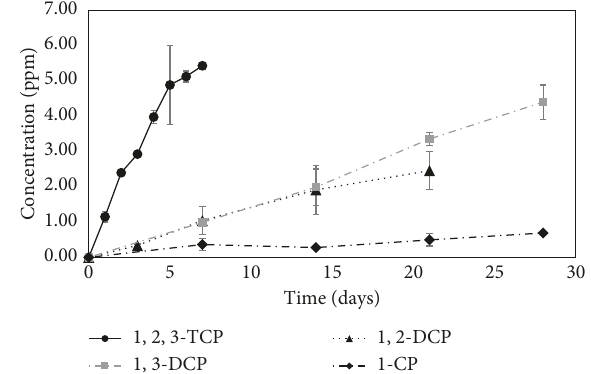
Figure 4: Increase of free chloride in solution of 1,2,3-TCP (12.27 mg/l), 1,2-DCP (9.48mg/L), 1,3-DCP (24.79 mg/L), and 1- CP (20.89 mg/L) in the presence of 1mM · B 12 and 0.5g of µ ZVI.